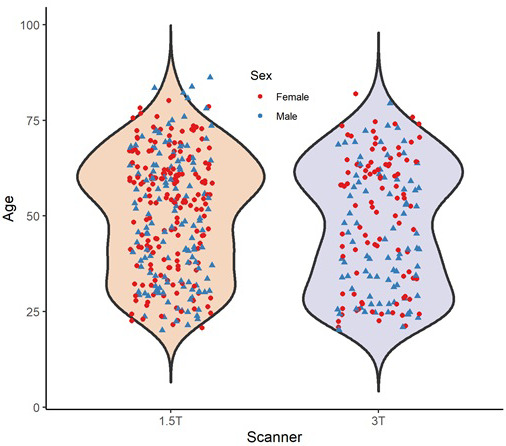
Age and sex distribution of complete IXI human sample (n = 496) separated by scanner field strength.